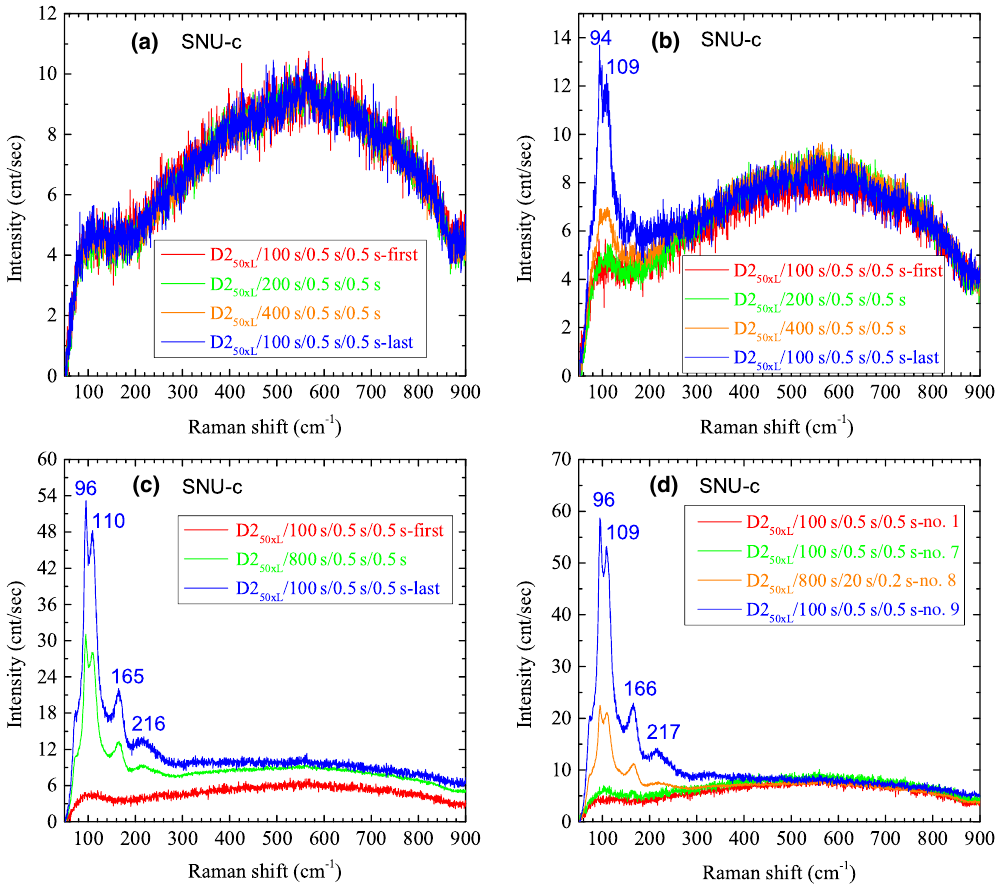
FIG. 6. Effects of multiple consecutive Raman measurements in SNU-c samples under D2 excitation. Panels (a) and (b) show spatial inhomogeneity. Panels (c) and (d) show the effect of long illumination